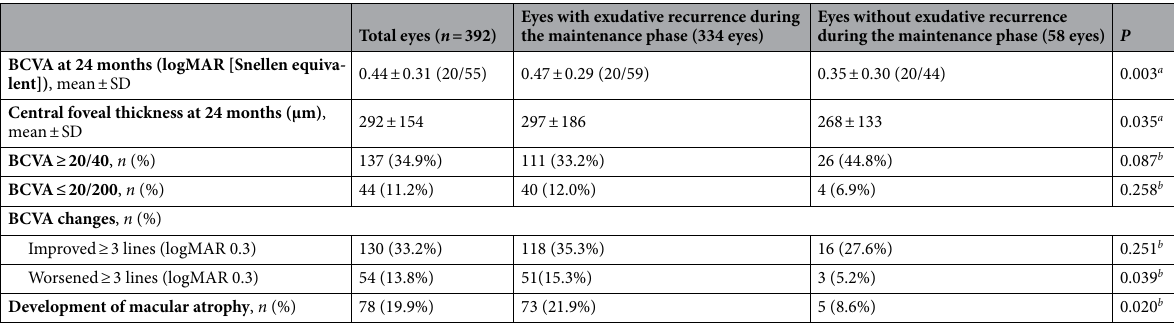
Anatomical outcomes. The mean central foveal thickness significantly decreased during the 24-month follow-up in both groups (Fig. 2). After 24 months of treatment, the mean central foveal thickness of the eyes without exudative recurrence was significantly lesser than that of the eyes with exudative recurrence during the maintenance phase (268 ± 133 µm vs. 297 ± 186 µm; P = 0.035) (Fig. 2). The incidence of MA development was significantly lower in the eyes without exudative recurrence than in the eyes with exudative recurrence (8.6% [5/58 eyes] vs. 21.9% [73/334 eyes]; P = 0.020) (Table 2). Odds for no exudative recurrence during the maintenance phase. Several significant baseline characteristics associated with the absence of exudative recurrence were identified using the multivariate logistic regression analysis (Table 3). Younger age at baseline (odds ratio [OR], 0.901; 95% confidence interval [CI], 0.831–0.979; P = 0.033) was associated with increased odds of no recurrence during the maintenance phase. Similarly, smaller lesion size (OR, 0.589; 95% CI, 0.383–0.901; P = 0.016) and absence of fibrovascular PED (OR, 1.349; 95% CI, 1.226–2.884; P = 0.028) were significantly associated with an increased likelihood of the absence of recurrence. However, serous PED was not significantly associated with absence of recurrence in the main-